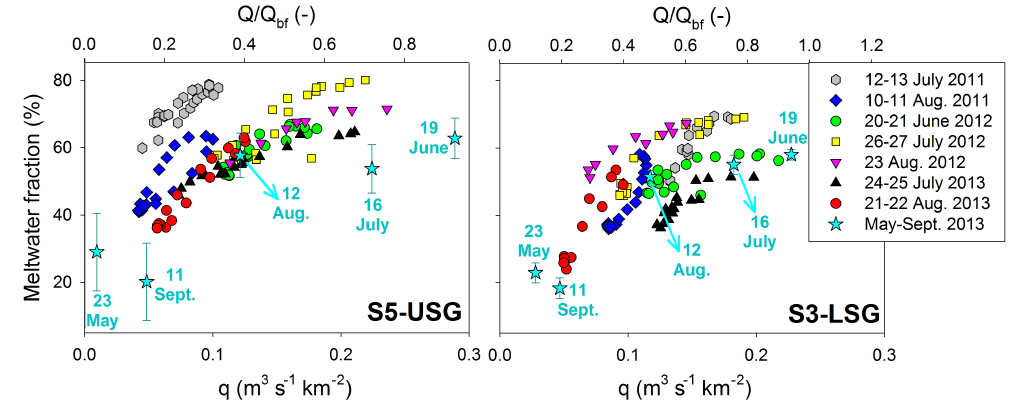
Figure 8. Relation between specific discharge ( q ) and meltwater fraction (%) in streamflow for the melt-induced runoff events in 2011, 2012 and 2013 sampled at hourly timescale (represented by different coloured symbols), and for the monthly sampling days in 2013 at S5-USG and S3-LSG (represented by stars in cyan). Meltwater fractions for the melt-induced runoff events were taken from Engel et al. (2016), while meltwater fractions for the monthly sampling days in 2013 are given by the average of the four different mixing models scenarios (presented in Fig. 5), and error bars indicate the standard deviation. For the double-peak event on 23–24 August 2012 at S5-USG, where a 9mm rainstorm superimposed the melt event (cf. Engel et al., 2016), only the melt-induced part of the event was considered. Discharge is reported also as fraction of the bankfull discharge Q bf at the two